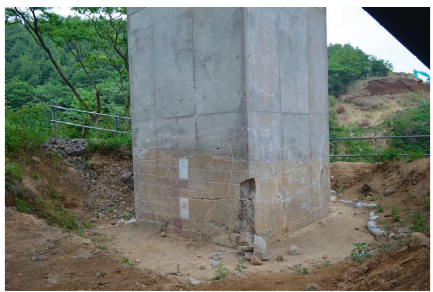
Figure 19: Cracks at the base of the